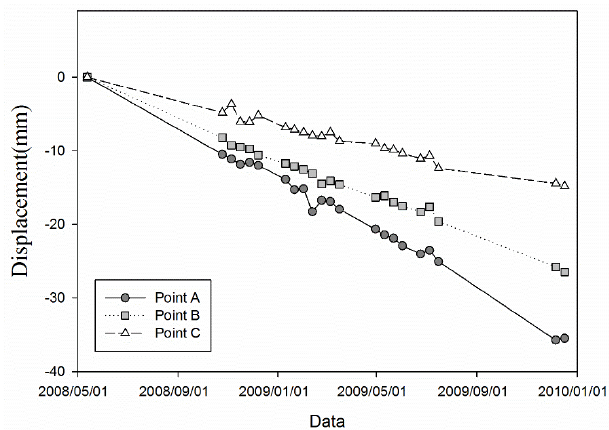
Figure 13. The LOS deformation velocity results of HKSP from TerraSAR-X Stripmap images retrieved by the PSI method ( a ) and the proposed DSI strategy ( b ).